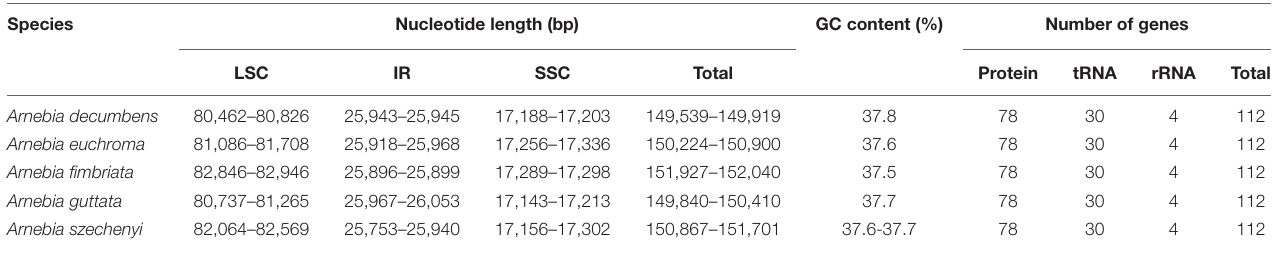
TABLE 1 | Chloroplast genome features of the five Arnebia species. Species Nucleotide length